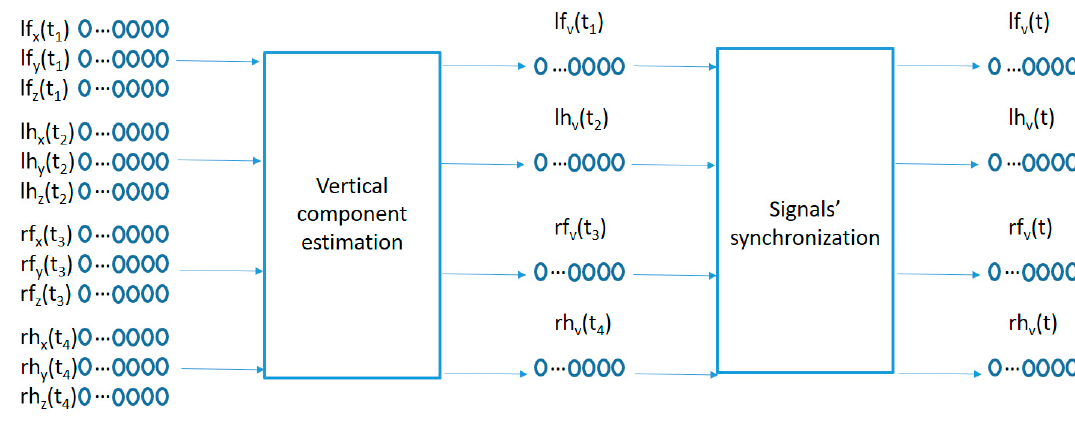
Figure 3. Signal preprocessing.